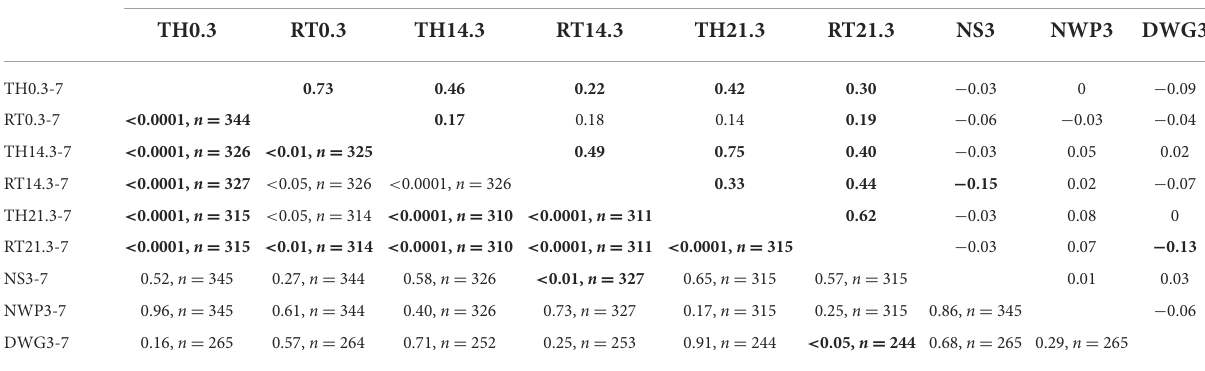
TABLE 5 Pearson correlation coefficient between thermographic skin temperature, rectal temperature, stillborn piglets, number of weaned piglets and daily weight gain of suckling piglets of third to seventh parity